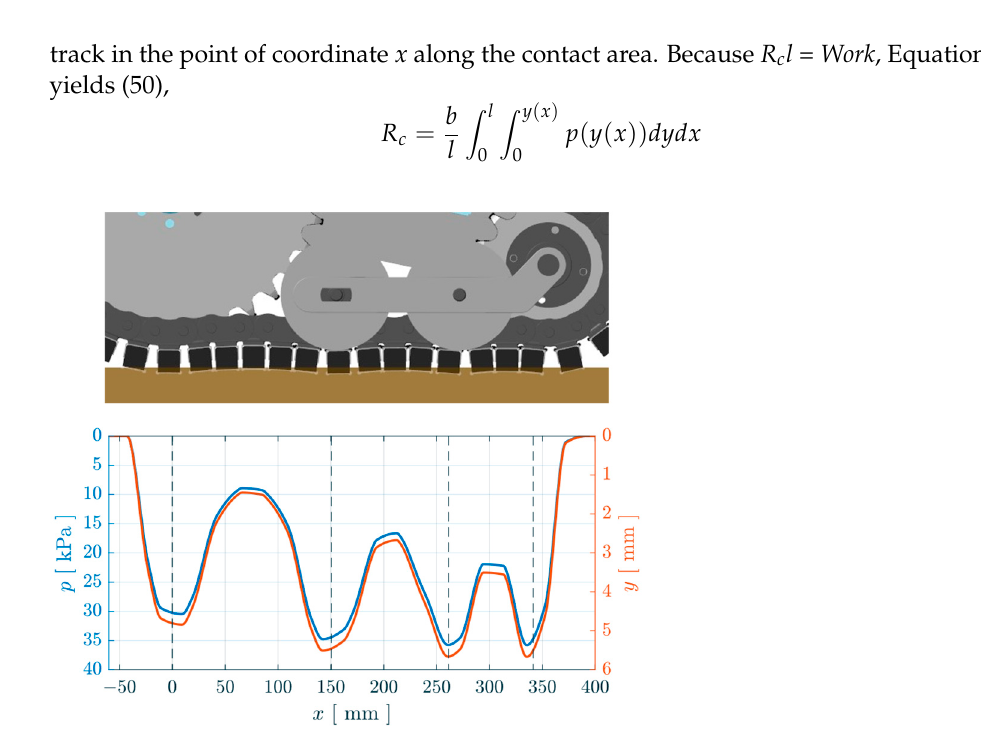
Figure 19. Normal pressure distribution (left y axis) and sinkage (right y axis) of the reconfigurable module in track mode.